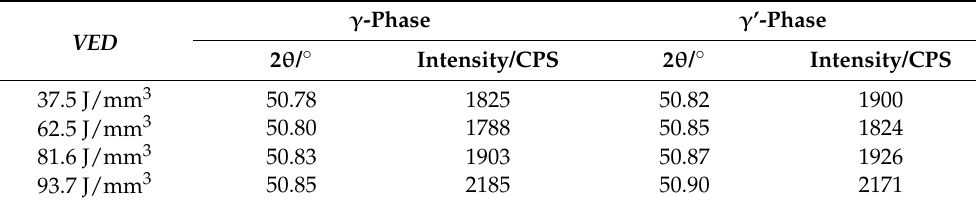
Table 3. Variation of diffraction peaks of γ -phase and γ ’-phase under different energy densities. γ -Phase γ ’-Phase VED 2 θ /